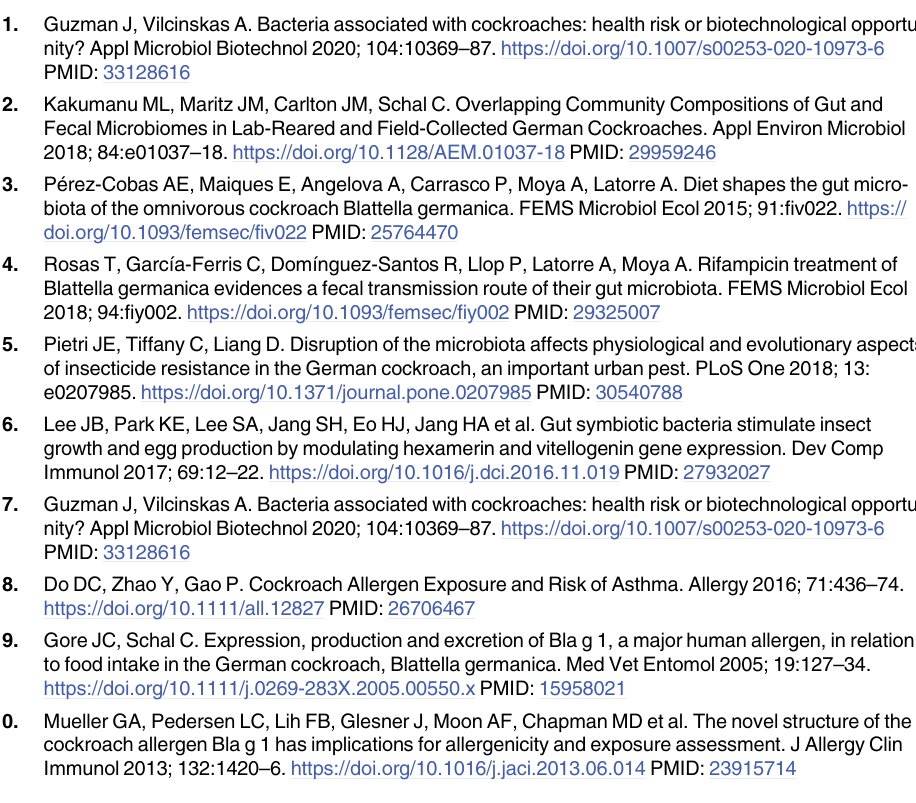
S2 Fig. Allergen levels in the extracts from the two cockroach groups. Concentrations of (A) Bla g 1, (B) Bla g 2, and (C) Bla g 5 in the extracts were measured using enzyme-linked immu- nosorbent assays. (TIF) S1 Table. List of differentially expressed genes (DEGs) between the control and ampicillin- treated